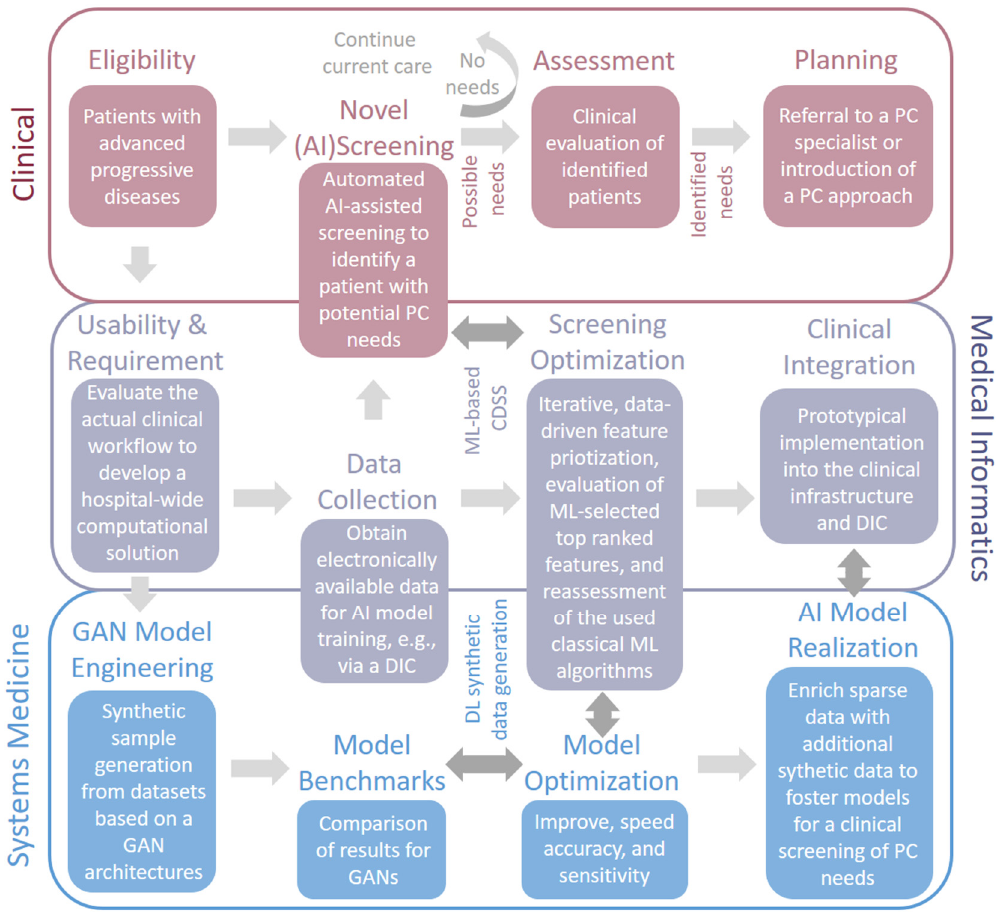
Figure 2. Scheme to illustrate the mutual cooperativity between the fields of Systems Medicine, Medical Informatics, and the clinical domain of Palliative Care (PC). The schematic representation is a content-wise extension of ElMokhallalati et al. [82], who only considered the clinical aspect.